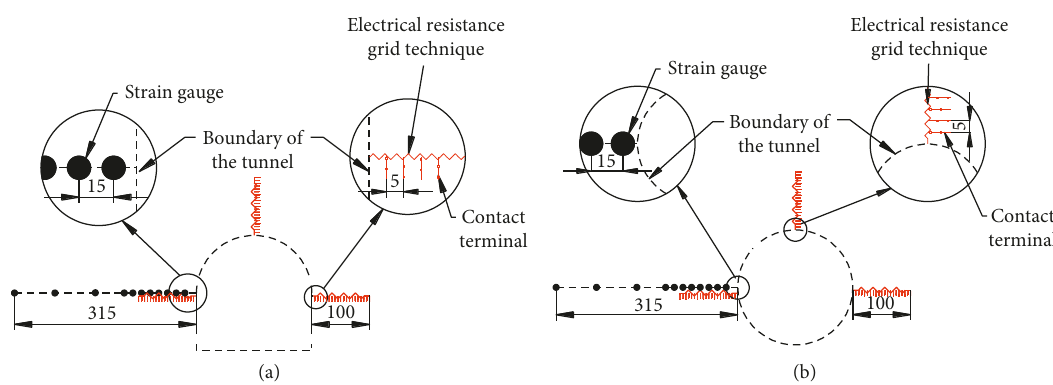
Figure 5: Strain gauge layout and the electrical resistance grid technique in the model. (a) Horseshoe tunnel. (b) Circular tunnel.